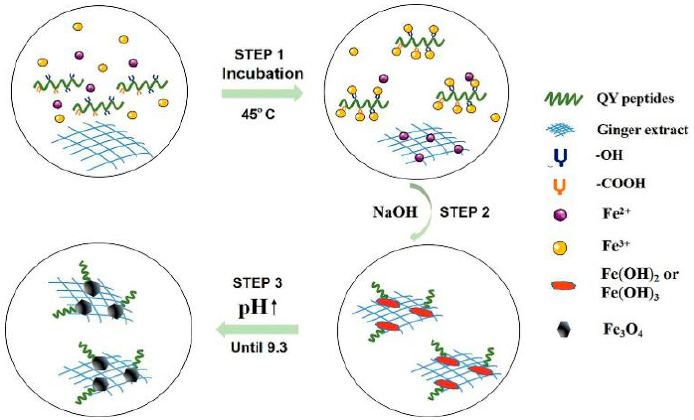
Figure 11. Possible formation mechanism of Fe 3 O 4 ‐ QY ‐ G nanoparticles.